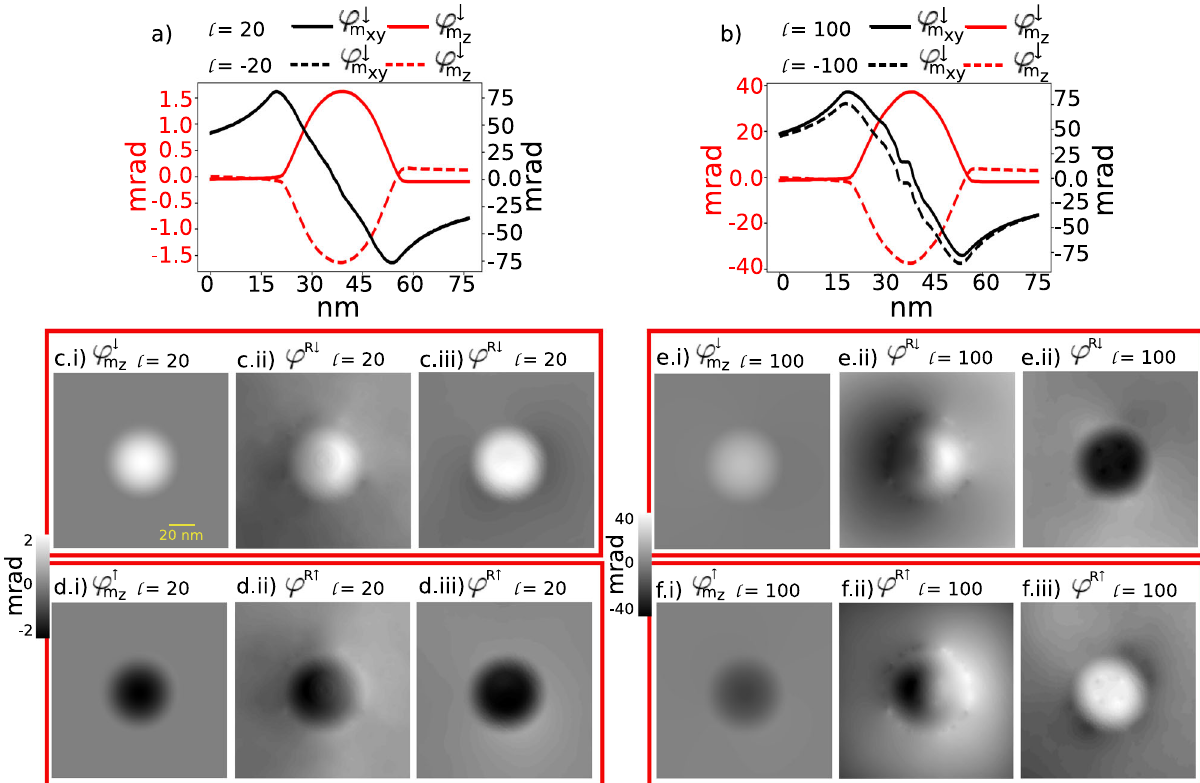
Fig. 3 Simulated phase shifts from a magnetic nanoparticle and implementation of the OAM-based transport-of-intensity equation (TIE). a and and φ m , from a simulated Permalloy nanoparticle b Magnetic phase shifts from the in-plane component and out-of-plane component of magnetization, φ m xy z with orbital angular momentum (OAM) l = ± 20 and l = ± 100, respectively. The nanoparticle is oriented with the out-of-plane magnetization in the negative z -direction, indicated with the ↓ superscript. The phase shifts, φ m , and reconstructed phase shifts, φ R , for the nanoparticle and shown in z , the phase reconstructed from images obtained at a single defocus value, c , d , e , and f . Columns (i), (ii), and (iii) correspond to the simulation of the φ m z and the phase reconstructed from both overfocused and underfocused images; phase indicated by the color bars. c Phase shifts for electron vortex beam (EVB) with OAM = 20 imparted by a nanoparticle with out-of-plane magnetization in the negative z -direction ( ↓ ). d Phase shifts for EVB with OAM = 20 imparted by a nanoparticle with out-of-plane magnetization in the positive z -direction ( ↑ ). e Phase shifts for EVB with OAM = 100 imparted by a nanoparticle with out-of-plane magnetization in the negative z -direction ( ↓ ). f Phase shifts for EVB with OAM = 100 imparted by a nanoparticle with out-of- plane magnetization in the positive z -direction ( ↑